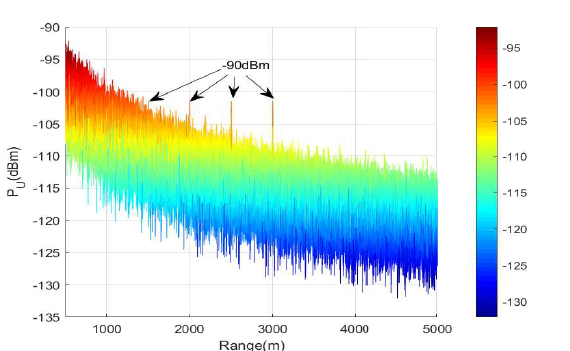
Figure 5. The spatial power distribution of confidential messages in range dimension.